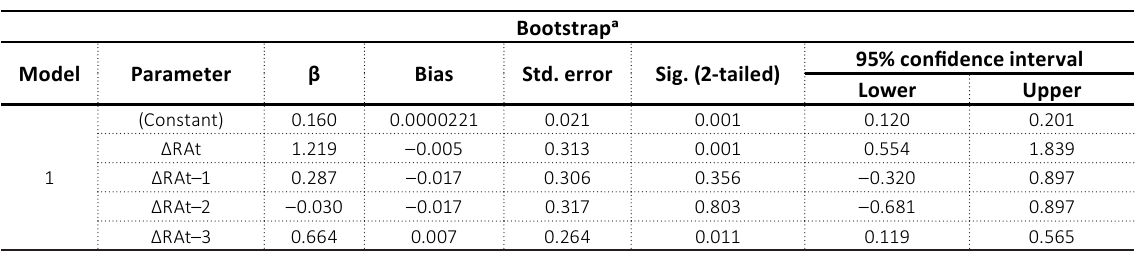
Table 7. CEO and Director total pay to